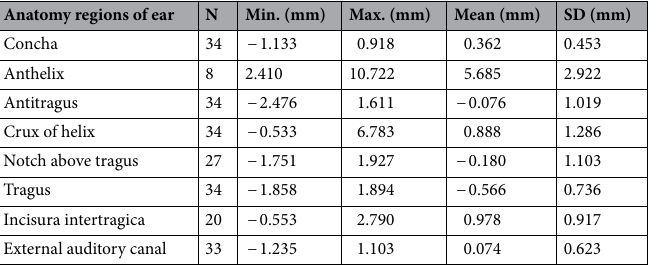
Table 5. The descriptive statistics on the deviation analysis result of deviation analysis algorithm. **Correlation is significant at the 0.01 level. *Correlation is significant at the 0.05 level. Algorithm = Deviation analysis algorithm.